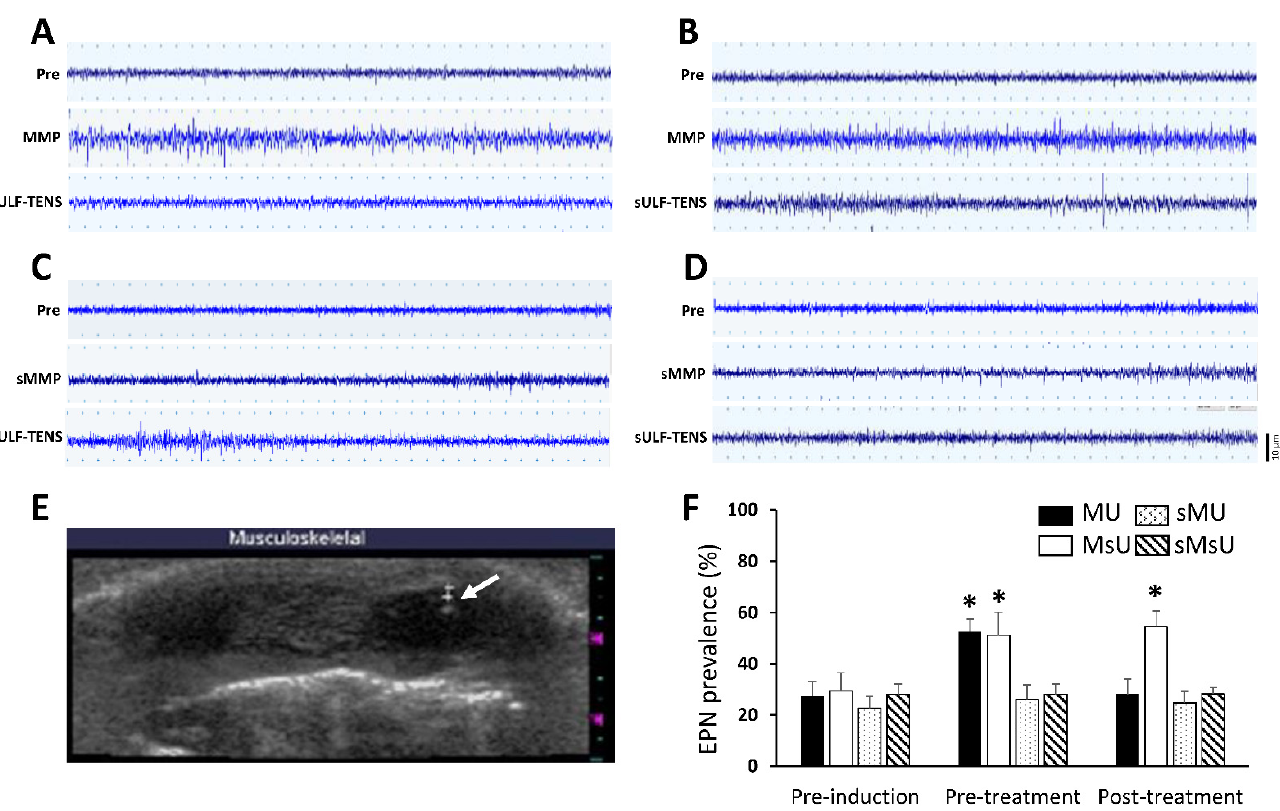
Figure 1. Representative examples of typical EMG activities of EPN from myofascial trigger points of masseter muscle in MU ( A ), MsU ( B ), sMU ( C ), and sMsU ( D ) groups recorded under ultrasonic guidance ( E ). Note that myofascial trigger points are visualized as a hypoechoic region with an elliptical appearance under ultrasound imaging. Alterations of EPN prevalence recorded from masseter muscles at pre-induction, pre-treatment, and post-treatment time points of four groups are shown ( F ). *: p < 0.0083 indicates significant differences between either sMU or sMsU group tested by Mann–Whitney test. Table 1. The prevalence of endplate noise and maximum jaw-opening distances at each evaluation time in four groups.